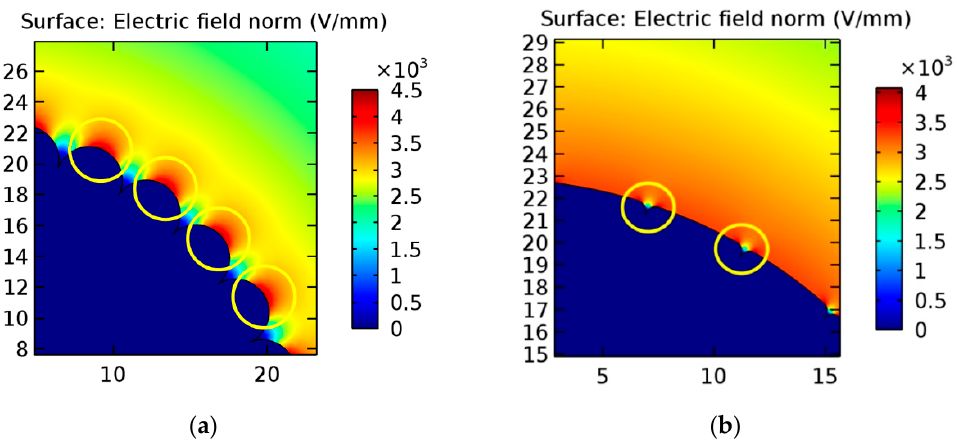
Figure 4. ( a ) Potential difference and ( b ) field distribution apropos of the proposed pliable GIL regarding specimen 3 of Table 2.